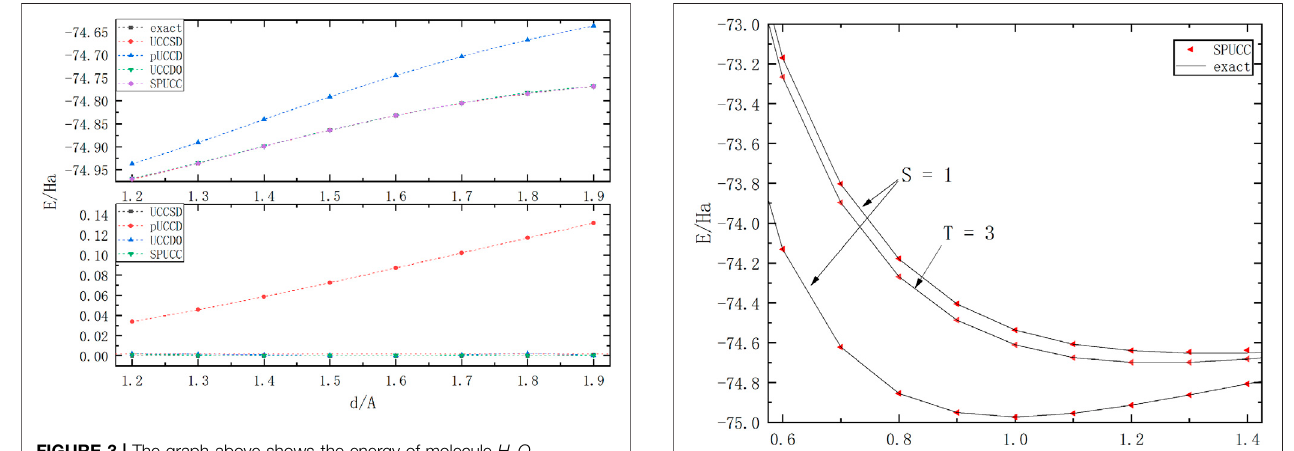
FIGURE 3 | The graph above shows the energy of molecule H 2 O ( α (cid:1) 104 . 5 ° ) varies with the bond length (6 electrons and 10 orbitals). The following fi gure shows the difference of the energy of each method and exact diagonalization with different bond lengths. The red dotted line represents the chemical precision of 1 . 6 × 10 − 3 Ha .